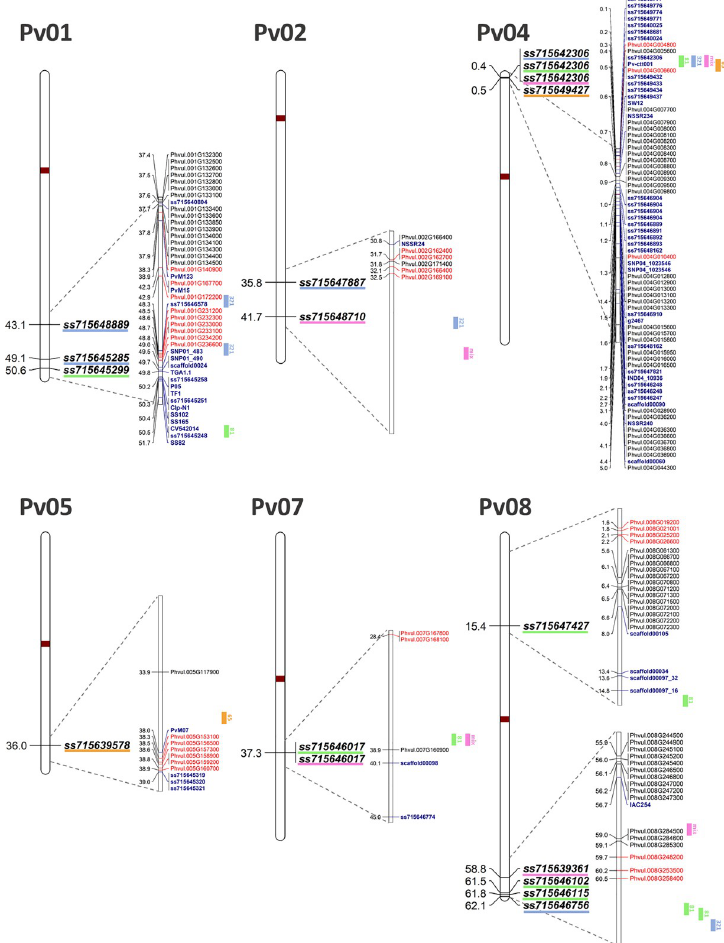
Fig 4. MapChart showing the simple nucleotide polymorphism associated with multi-race anthracnose resistance loci . Each chromosome represents the physical position of the simple nucleotide polymorphisms (SNPs) significant for the three races of anthracnose used independently and for the mixture of races in the genome-wide association study (GWAS). The significant quantitative resistance loci (QRL) are represented by orange, green, blue, and pink bars on the right side of the chromosomes for races 65, 81, 321, and the mixture of races, respectively. The part of the amplified chromosomes shows the physical position of the main genes involved in the disease resistance response: the R genes (containing nucleotide-binding and leucine-rich repeat domains—NB-LRR) in black and in a position according to Schmutz et al. [8], and the genes encoding kinases in red, according to Bisneta and Gonc¸alves-Vidigal [89]. Markers associated with the resistance loci found in previous studies are highlighted in dark blue. Centromeric regions are represented in brown and physical positions provided in Megabase pairs (Mbp), according to the reference genome: Phaseolus vulgaris